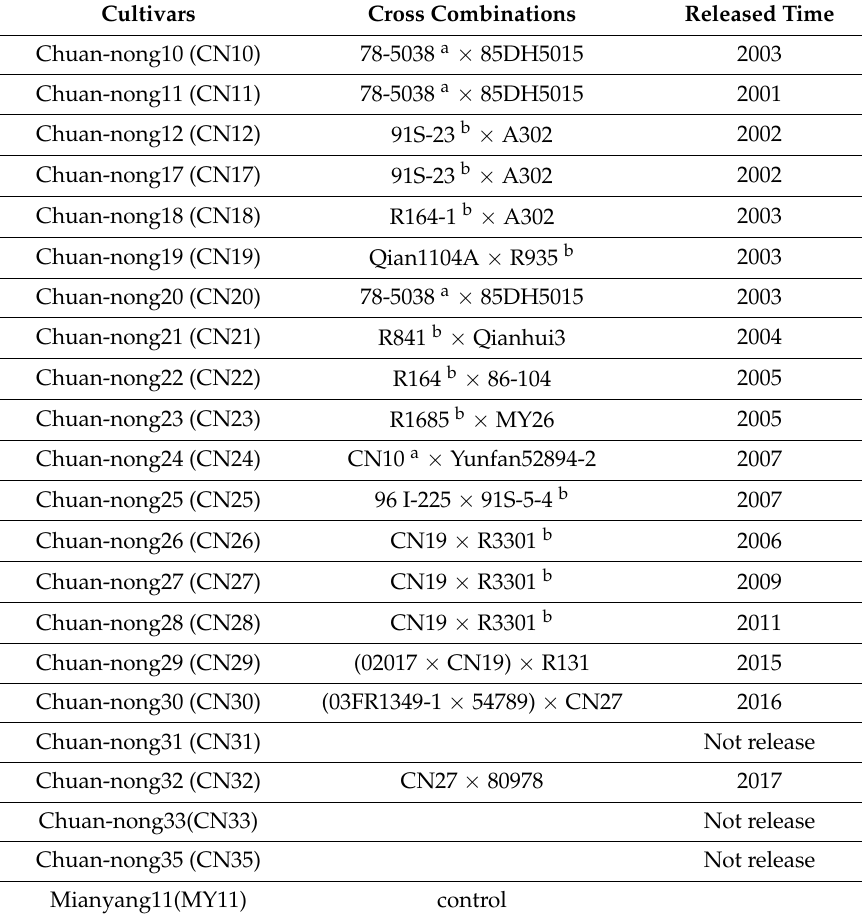
Table 1. The pedigree of “Chuan-nong” series wheat